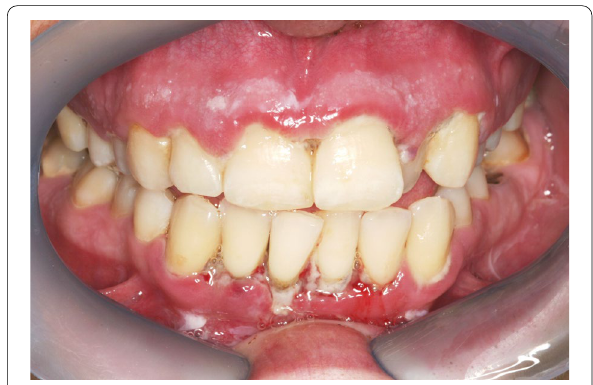
Fig. 3 Necrotising stomatitis lower labial mucosa, following necrotising gingivitis: ‘contact’ spread: young HIV-seropositive